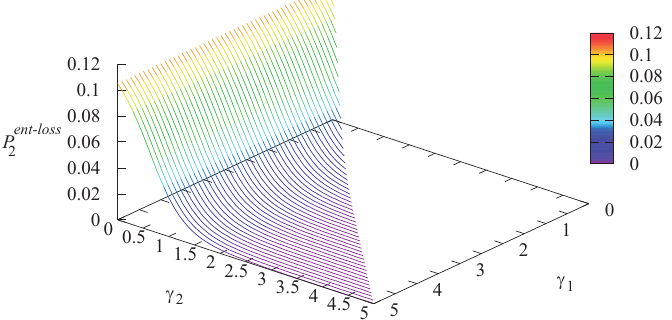
Figure 3. Dependence of the probability P ent − loss arrival due to Storage 2 overflow on γ 1 and γ 2